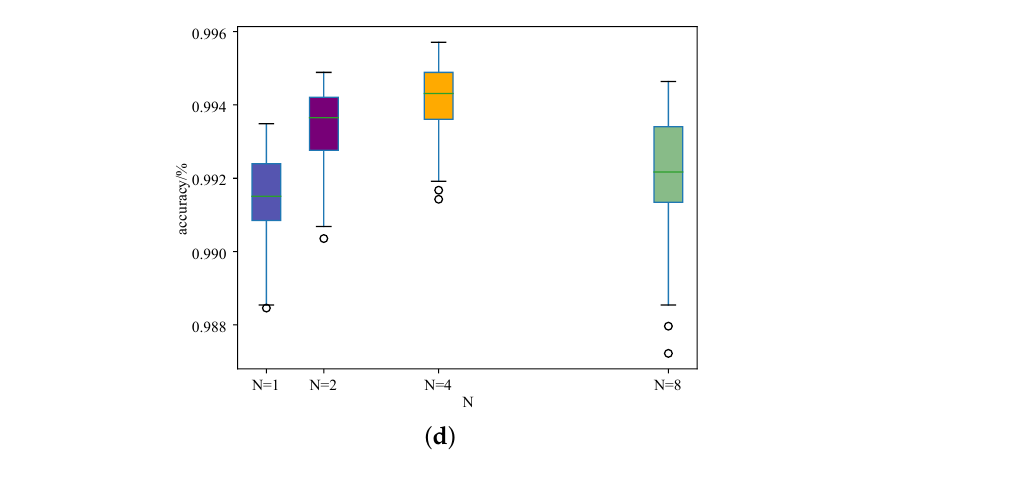
Figure 10. Boxplots of the recognition accuracy of different N values under different labeled samples in each category on the MSTAR data set. ( a ) 10; ( b ) 20; ( c ) 40; ( d ) 80.